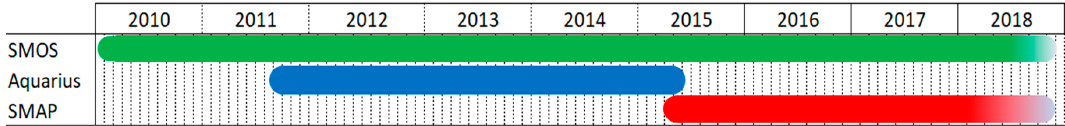
Figure 1. Timeline of satellite sea surface salinity (SSS) products availability. The Soil Moisture and Ocean Salinity (SMOS) SSS is available starting Jan 2010 (onward). The Aquarius product is available from Aug 25, 2011 until June 7, 2015 when the spacecraft bus failed. The Soil Moisture Active Passive (SMAP) product is available starting April 2015